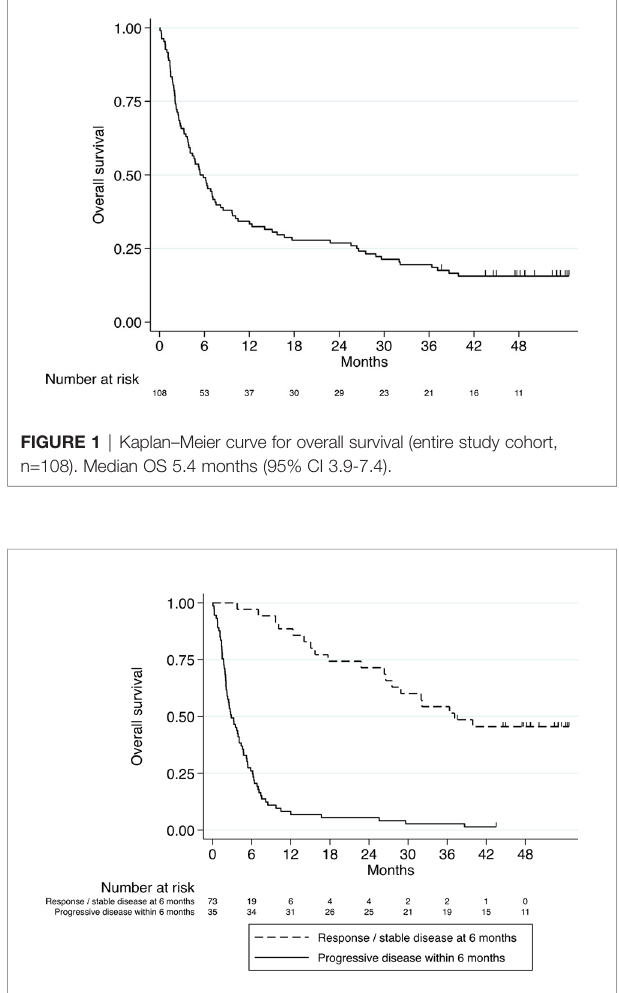
FIGURE 2 | Kaplan – Meier curve for overall survival strati fi ed according to DC6 (n=35) vs. non-DC6 (n=73) patients. HR 0.12, 95% con fi dence interval (CI) 0.07-0.21, p<0.001.